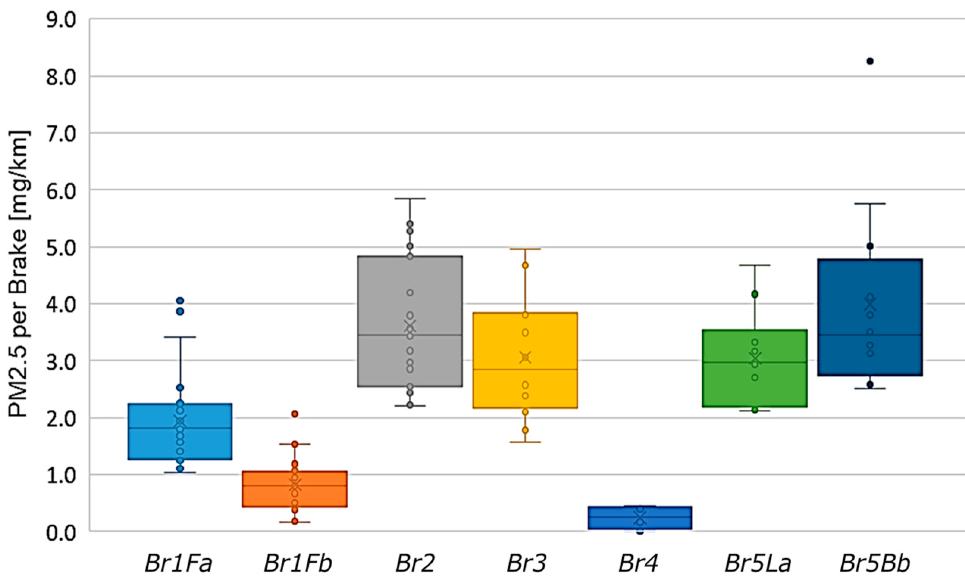
Figure 3. Overview of the PM2.5 measurement results for all brakes. The minimum, first quartile, median (denoted with the horizontal line), average (denoted with the “×”), third quartile, and maximum statistical variables are included in the chart. Outliers are denoted, too.